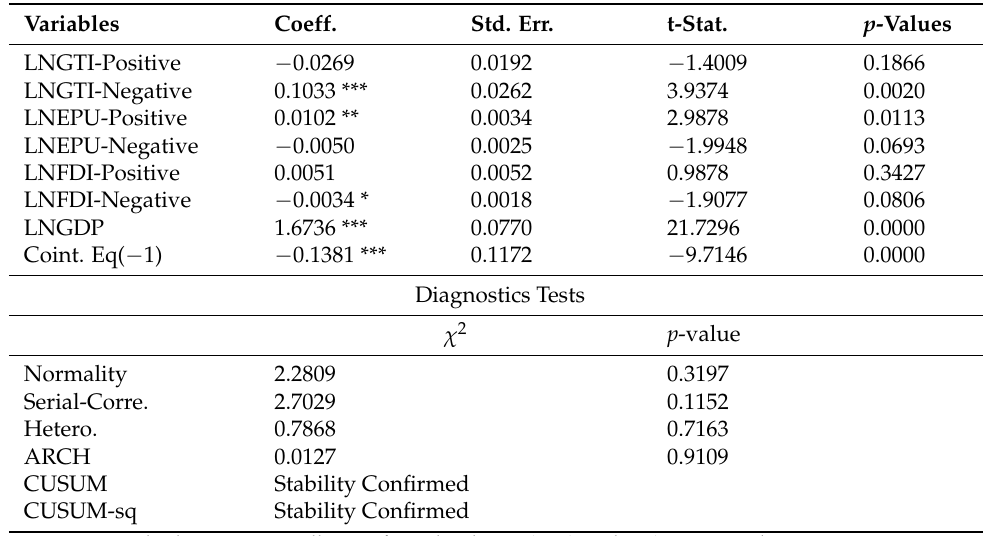
Table 12. NARDL short-run estimates and diagnostics